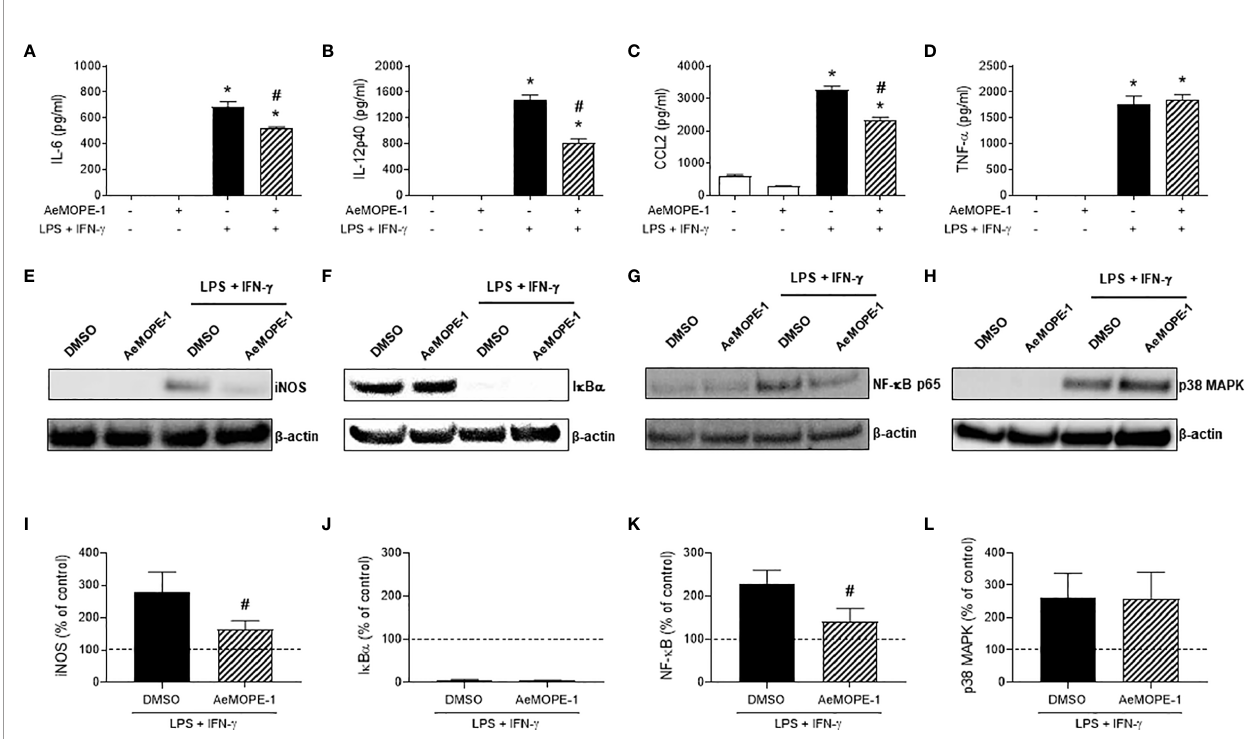
FIGURE 5 | Syn-AeMOPE-1 selectively modulates macrophage activation. Macrophages were pre-incubated with syn-AeMOPE-1 (2 µM) and stimulated with LPS + IFN- g (10 ng/mL of each). After 48 hours the production of cytokines (A) IL-6, (B) IL-12p40, (C) CCL2, and (D) TNF- a were detected in supernatants by ELISA. Values are expressed as the mean ± SEM (n = 4). * P ≤ 0.0001 versus unstimulated/untreated cells; # P ≤ 0.0001 versus LPS+IFN- g -stimulated cells – One-way ANOVA. Representative Western blots and densitometry for (E, I) iNOS, (F, J) I k B a , (G, K) NF- k Bp65, and (H, L) p38-MAPK performed with cell lysates at different time points. Results are expressed as the mean ± SEM from three independent experiments. # P ≤ 0.05 versus LPS+IFN- g -stimulated cells – Student ’ s t